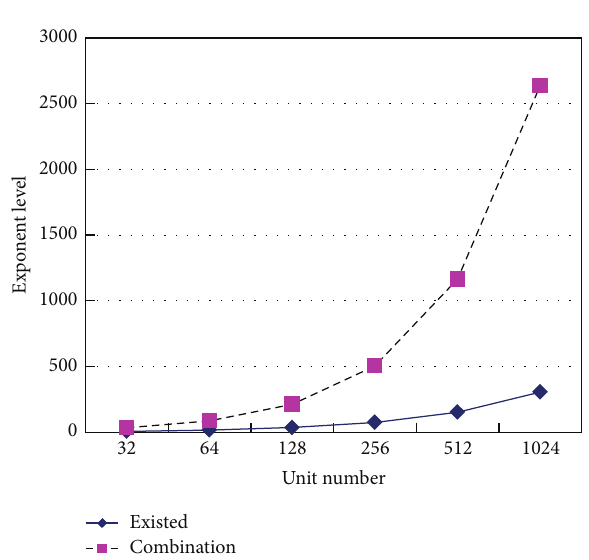
Figure 9: Key space of different encryption